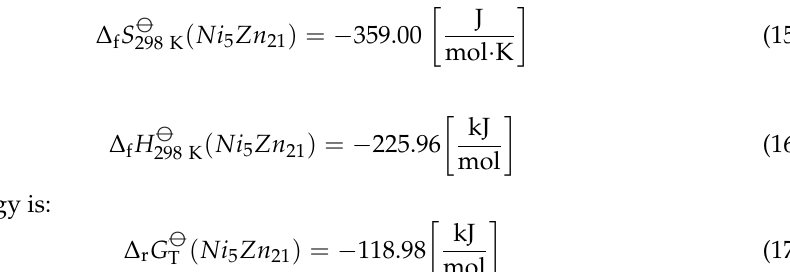
Table 13. Comparison of performance parameter of electrical discharge machining alumina based on the use of assistive tools. The enthalpy of the formation for reactions NiO (12) and AlNi (15) is less than zero; thus, these reactions spontaneously take place with the release of heat in contrast to an- other reaction. Table 15 shows the calculated entropy, Gibbs energy, and equilibrium temperature. In NiO (12) and AlNi (15) reactions, the entropy is above zero, corre- sponding to an increase in the degree of chaos (gases of H ₂ and O ₂ ). That can be con- firmed visually by the appearance of gas bubbles during machining. When entropy is less than zero in the formation Ni ₅ Zn ₂₁ (14), reactions occur with a decrease in the degree of chaos (compound solidification). The calculated Gibbs energy for reaction with Ni ₅ Zn ₂₁ (14) is less than zero when Gibbs energies for reactions with NiO (12) and AlNi (15) are above zero. It means that the reaction under normal conditions can only pass in the re- verse direction: the formation of NiO (12) and AlNi (15) occurs with heat absorption when equilibrium temperatures (672.8 K and 3253.0 K, correspondingly) are achieved. Thus, the reaction of Ni and Zn is more likely with the presence of nickel-containing coating and brass wire since it does not require heat adsorption (Figure 9). As can be seen, the superior role in the formation of conductive debris in the interelectrode gap may play the chemical composition of the primary electrode (zinc of brass) in combina- tion with the Ni-coating of the alumina workpiece machined in a water medium. Table 15. Calculated entropy of some Ni-containing substances and equilibrium temperatures.